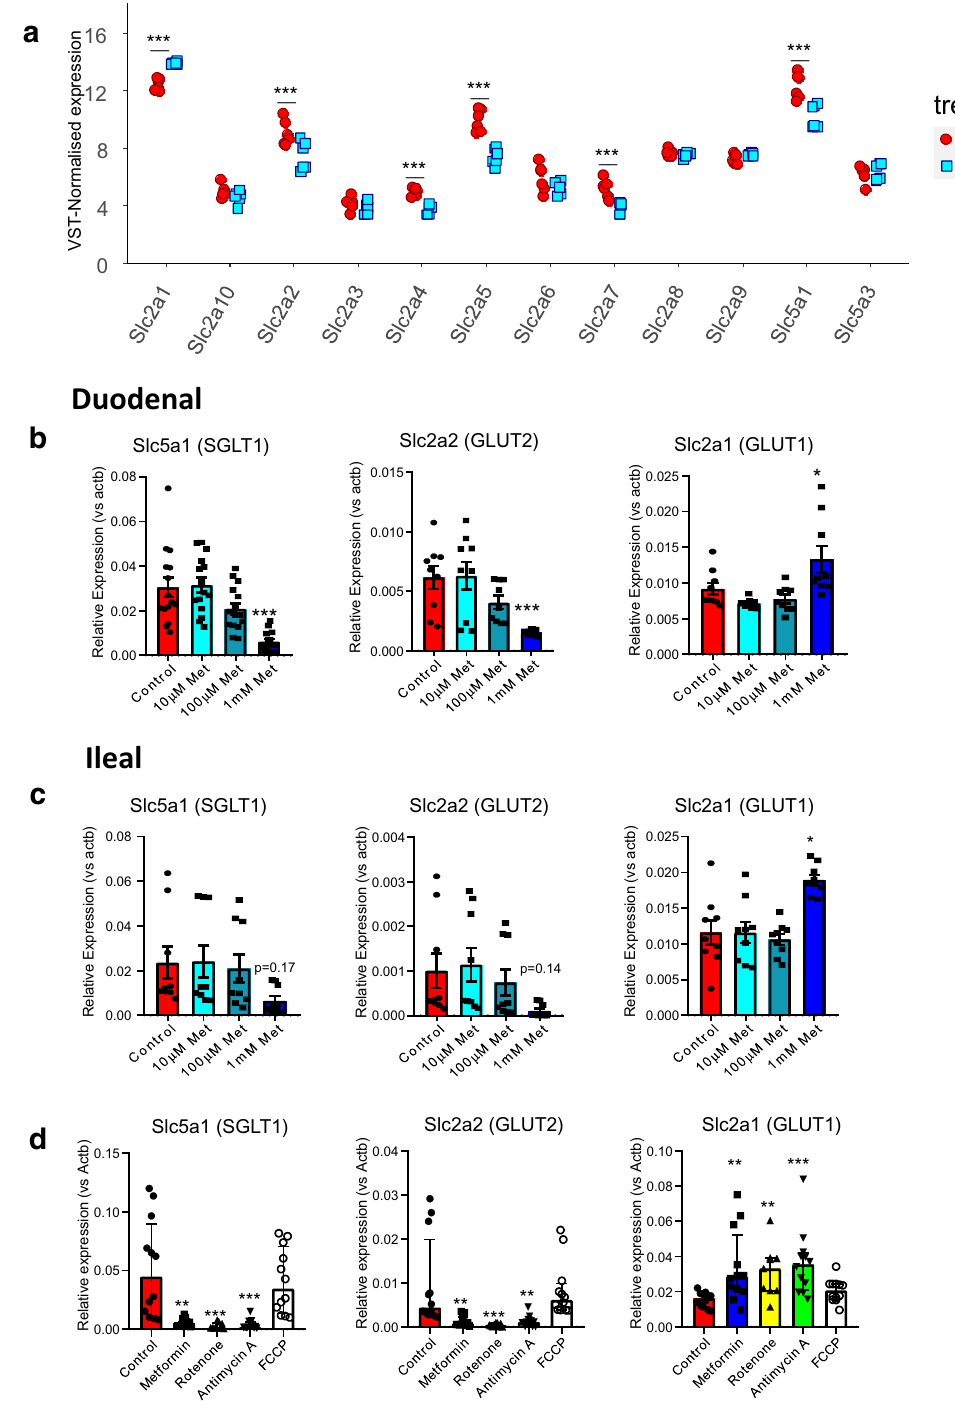
Figure 3. Metformin and other mitochondrial respiration inhibitors decreased expression of glucose transporters but increased Slc2a1 (GLUT1) expression. ( a ) RNA-sequencing analysis of the mRNA transcript expression of all GLUT ( Slc2aX ) transporter and SGLT ( Slc5aX ) transporter isoforms in duodenal organoid 2D monolayer cultures in response to 1 mM metformin pre-treatment for 24 h. ***P < 0.001 (p-adjusted value). DE-seq analysis and Benjamin-Hochberg corrections. Count data normalised by variance-stabilising transformation (VST) against size factors. Results are mean ± SEM. Each point represents a plate (n = 6 plates from 2 organoid lines). ( b ) qPCR analysis of glucose transporters Slc5a1 , Slc2a2 and Slc2a1 in mouse duodenal organoid derived 2D monolayer cultures in response to metformin pre-treatment from 10 µM to 1 mM for 24 h. n = 9 wells from 3 independent experiments except for Slc5a1 (n = 15 wells from 5 independent experiments). Results are mean ± SEM. *P < 0.05, **P < 0.01, ***P < 0.001. One way ANOVA and Bonferroni post-hoc test. ( c ) As ( b ) for mouse ileal cultures. n = 9 wells from 3 independent experiments. ( d ) qPCR analysis of expression of glucose transporters Slc5a1 , Slc2a2 and Slc2a1 in mouse duodenal organoid derived 2D monolayer cultures in response to metformin (1 mM), rotenone (10 μM), antimycin A (10 μM) and FCCP (10 μM) pre-treatment for 24 h. Results presented as median ± Interquartile range. n = 11–12 wells from 4 independent experiments. *P < 0.05, **P < 0.01, ***P < 0.001. Kruskal–Wallis and Dunn’s post-hoc test since the data did not pass normality